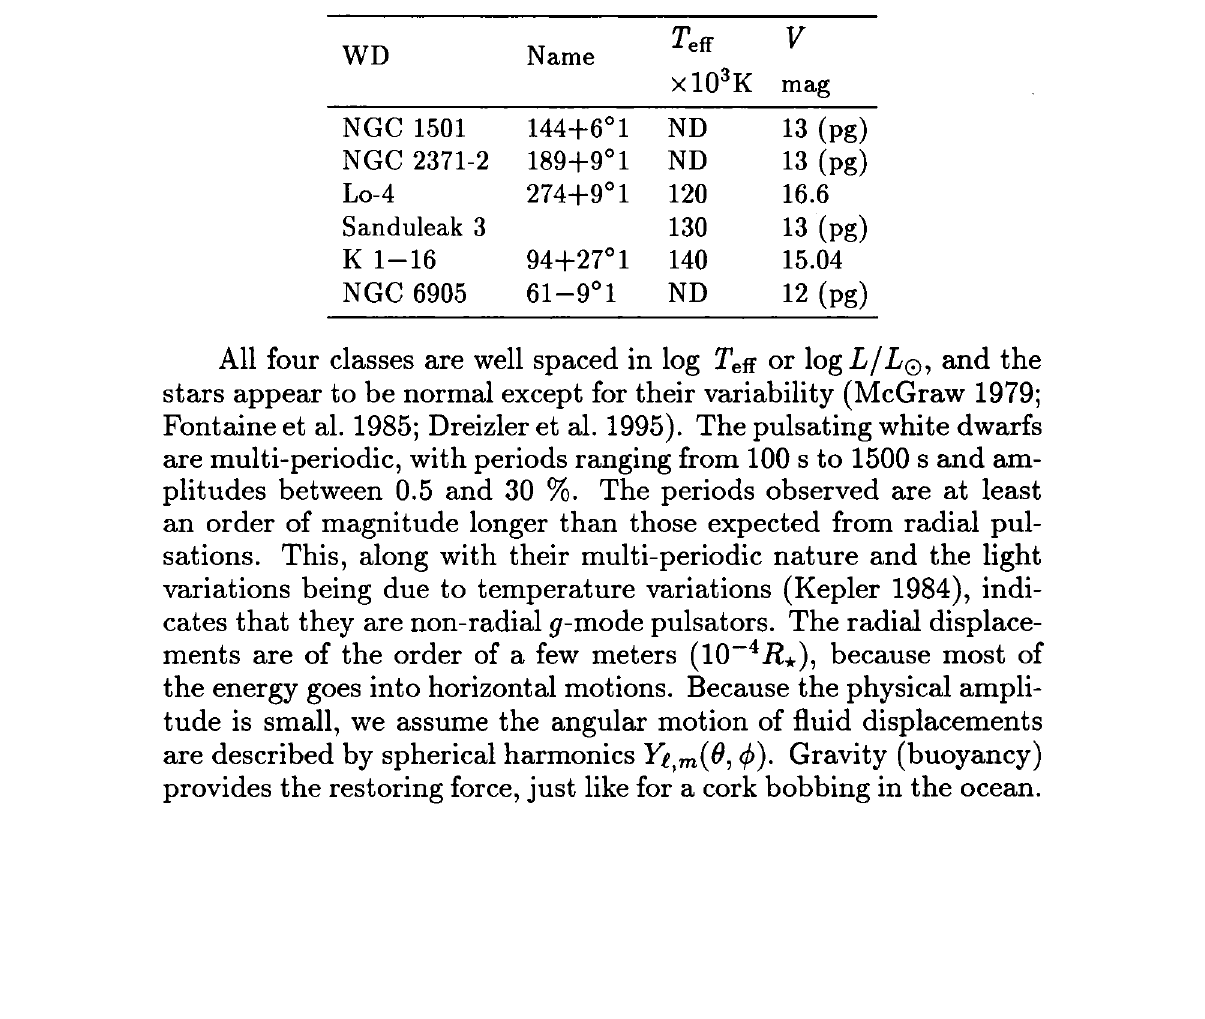
Table 5. Pulsating planetary nebula nuclei